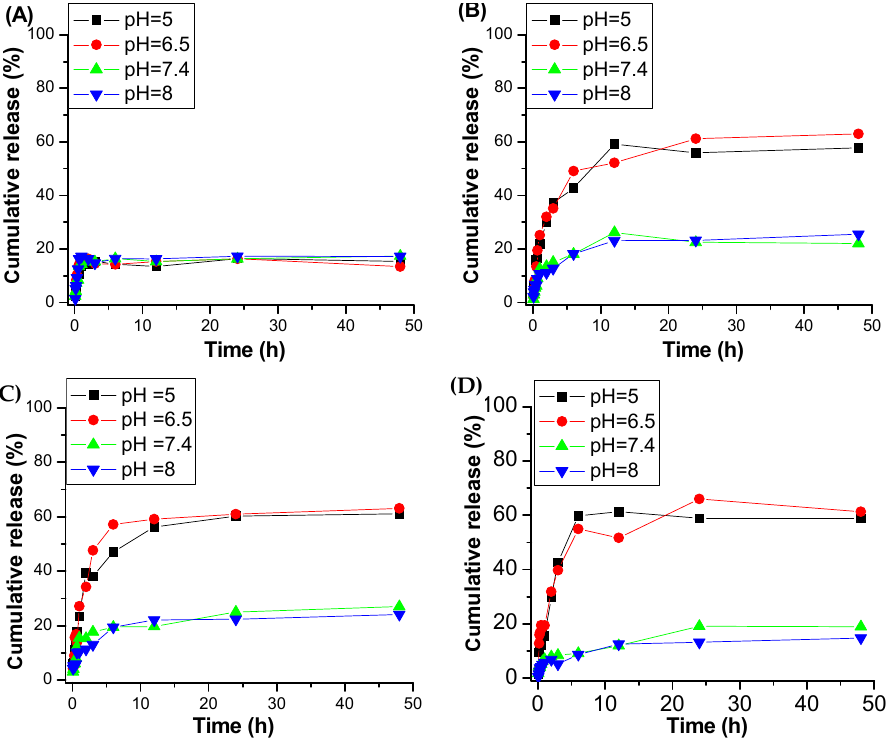
Figure 6. Dye release profiles of RhB loaded in ( A ) CTAB free MSNs, ( B ) MSNs–PDEAEMA, ( C )